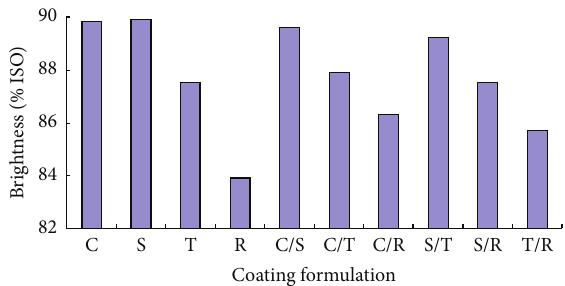
Figure 3: Effects of coating formulations on the brightness of coated papers, C: CaCO 3 ; S: SiO 2 ; T: talc; R: sericite, at mixing ratios of 50/50.